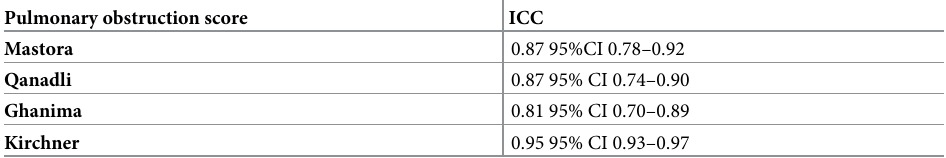
Table 2. Intraclass coefficients of the investigated pulmonary obstruction